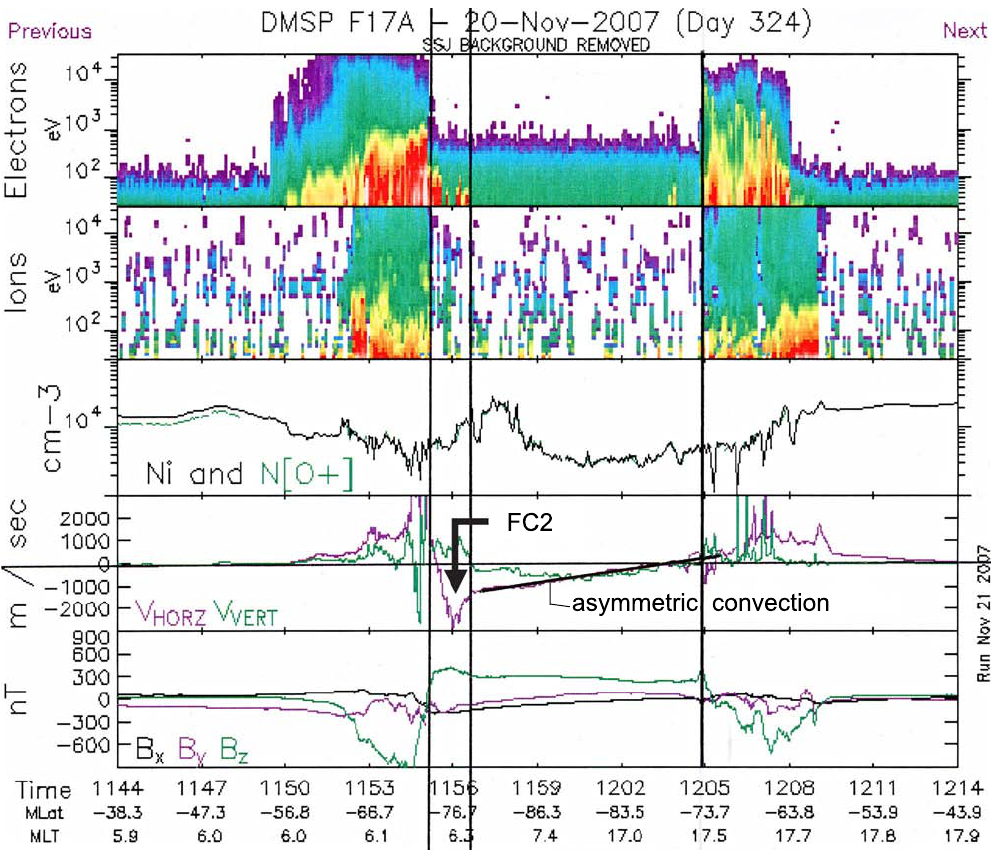
Fig. 15. DMSP data obtained by spacecraft F17 in the Southern Hemisphere during the interval 11:44–12:14UT on 20 November 2007. Same format as in Fig. 7. Flow channel FC 2 of category SH-dawn/ B y < 0 and asymmetric antisunward convection in the central polar cap have been marked.